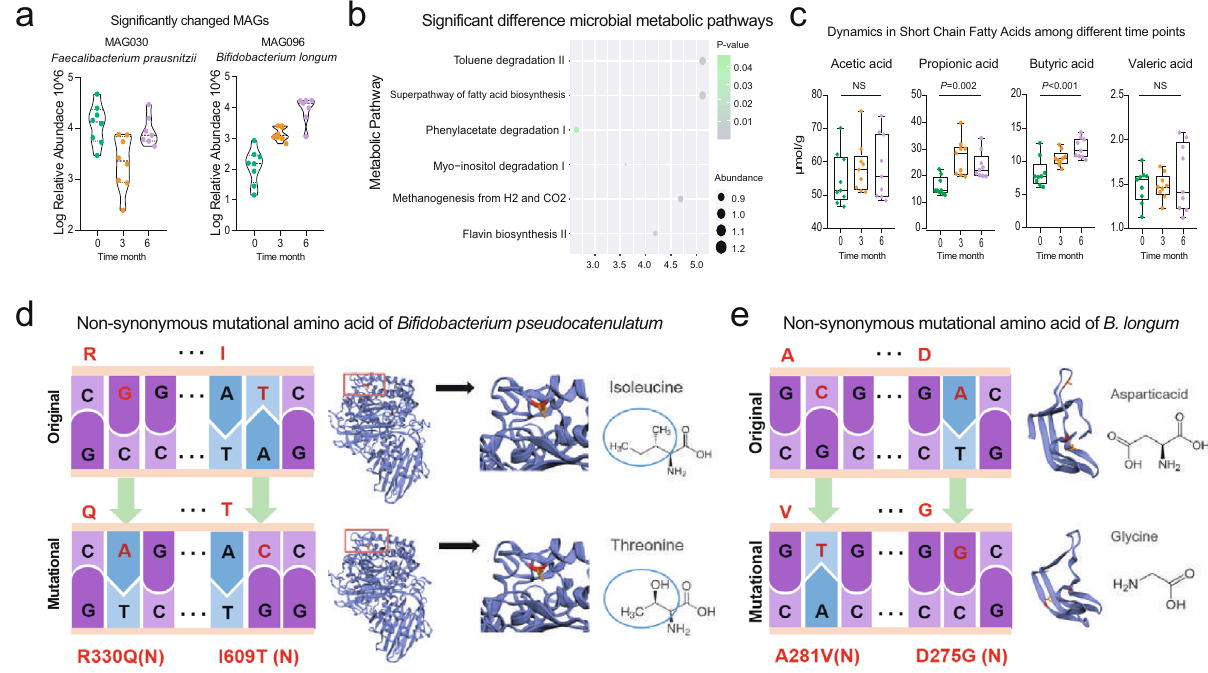
Fig. 7 Probiotic Bi fi dobacterium longum adjuvant methimazole treatment improved intestinal microbial structure. a MAGs of signi fi cant difference among different time points. b The intestinal microbial metabolic pathway that differed signi fi cantly between the samples at baseline and the samples with 6 months of probiotic and methimazole treatment. c Dynamics in Short-Chain Fatty Acids among different time points. d , e The evolutionary changes at the genetic level in intestinal microbial species that responded to probiotics intake. d Two SNPs (nonsynonymous mutations) were annotated at the Bi fi dobacterium pseudocatenulatum genome and the mutational gene was related to the function of Ig-like domain-containing protein. e The other two SNPs (nonsynonymous mutations) were annotated at the Bi fi dobacterium longum genome and the mutational gene was related to the function of LPXTG cell wall anchor domain-containing